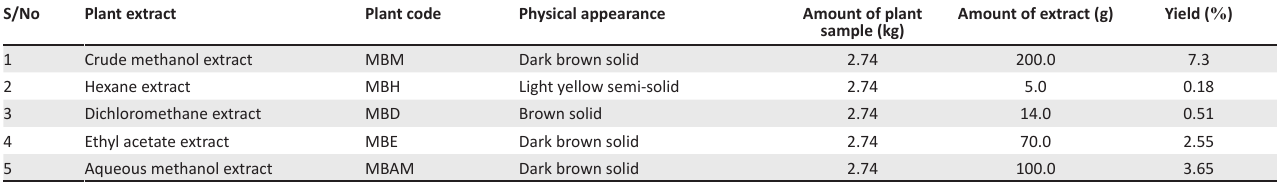
Table 1: Percentage yield and physical apperance of M. benthamianum extracts. S/No Plant extract